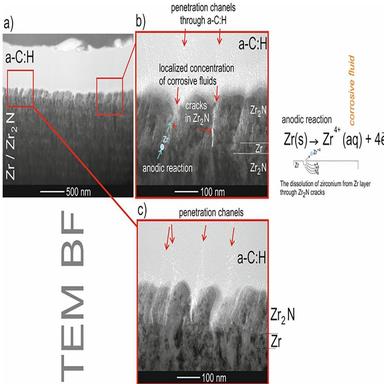
Higher magnification than presented on of the pitting corrosion mechanism of the Zr/Zr2N (1:4 ratio) multilayer coating with a-C:H top-layer coating by using a TEM BF technique presented the penetration channels through a-C:H layer; a). TEM BF image with the zoom marker of 500 nm; b). TEM BF image with the zoom marker of 100 nm, more concentrated on the penetration channels in Zr2N layer; c). TEM BF image with the zoom marker of 100 nm, more concentrated on the penetration channels in a-C:H lay